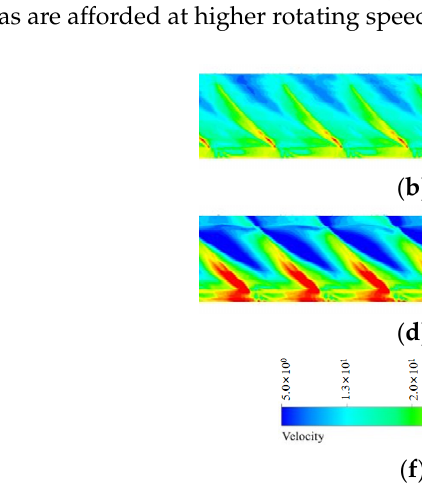
°= 01 β (Figure 22a–c), the low-velocity area of the rotor suction surface in-